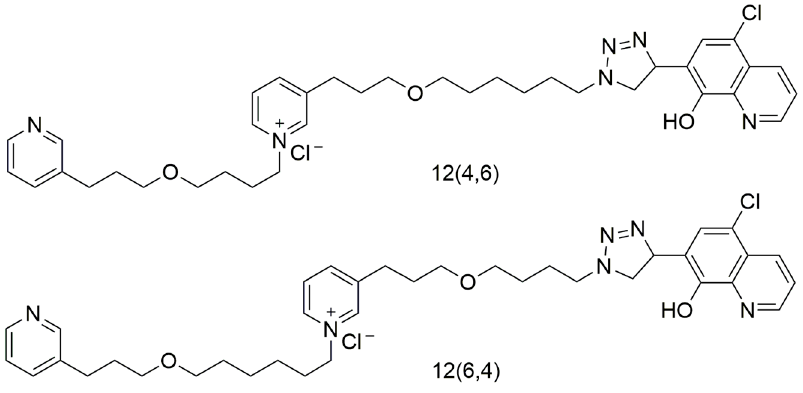
Figure 8. Structure of 12(4,6) and 12(6,4).